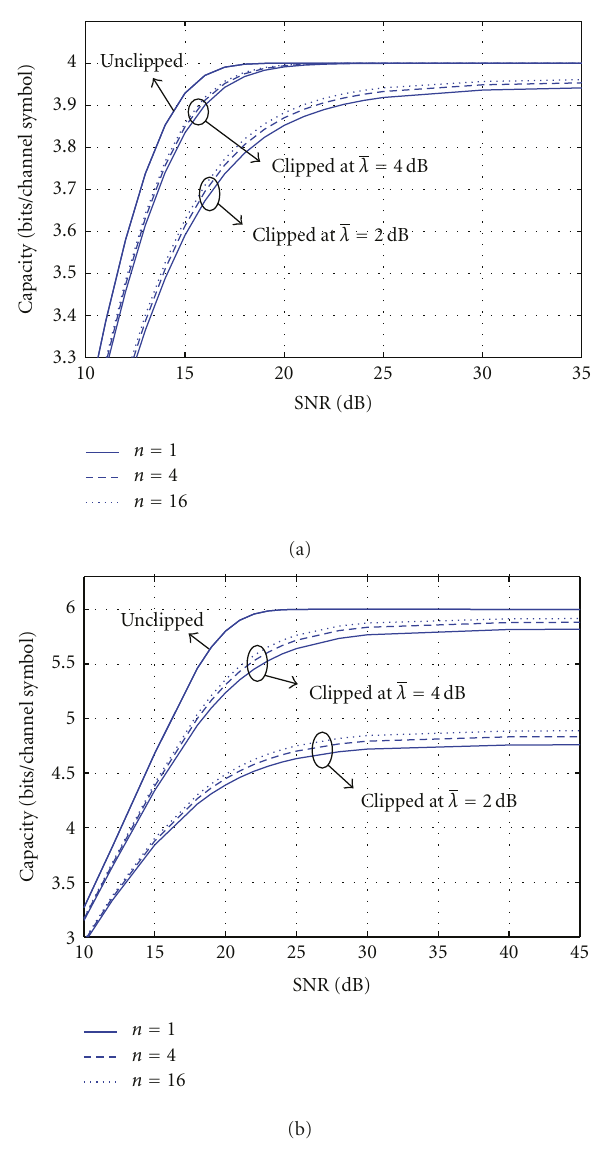
Figure 5: Channel capacity for 16-QAM case (a) and 64-QAM case (b), where N = 1024 and M-ary Input AWGN channel (MI-AWGN) is